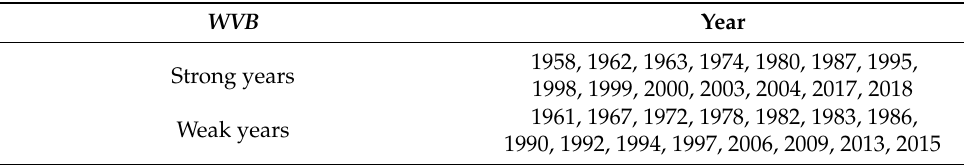
Table 3. Statistics of strong and weak years of summer WVB on the